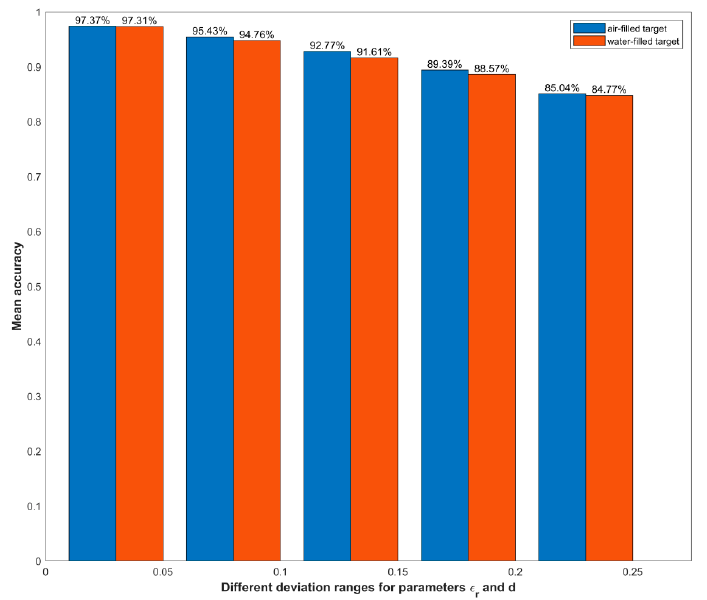
ε ε Figure 15. Statistical results of ε T for parameters ε r and d under different deviation Figure 15. Statistical results of T for parameters r and d under different deviation ranges.